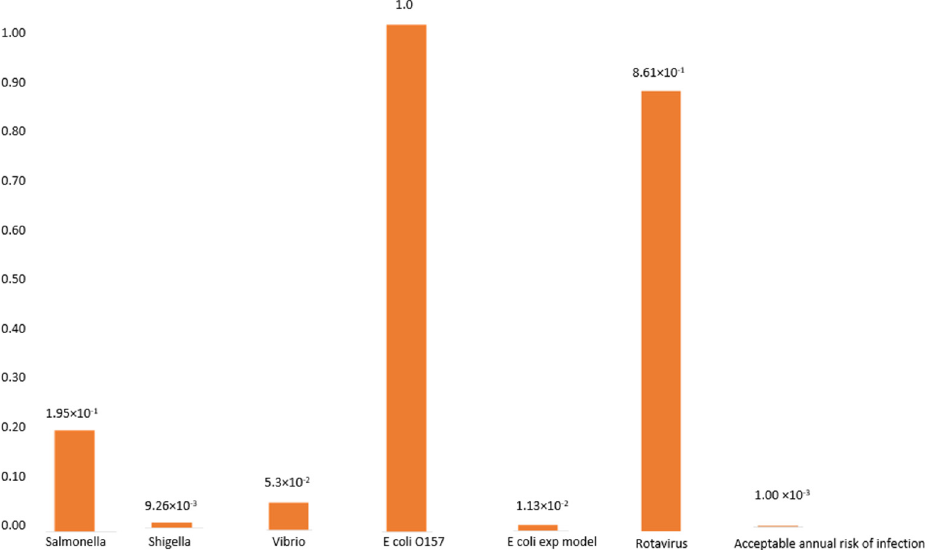
Figure 2. Probability of infection associated with the weekly consumption of water infected with enteric pathogenic microorganisms in the alternating months of November – August. enteric pathogenic microorganisms in the alternating months of